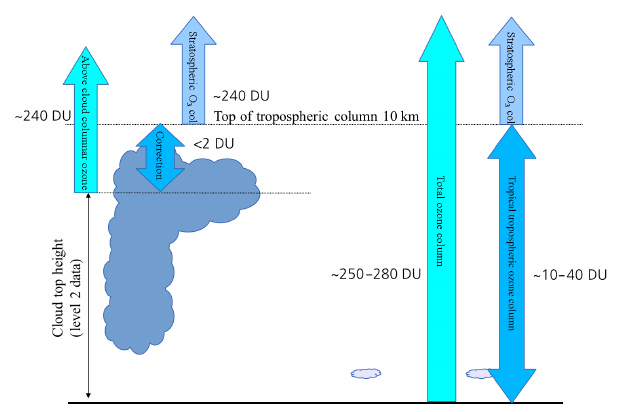
Figure 1. Sketch of the CCD method. The left side illustrates the estimate of the SCO using large convective clouds. In this case the cloud top is below 10km, hence the correction column is subtracted. On the right the cloud-free measurements of the total column and the TCO are